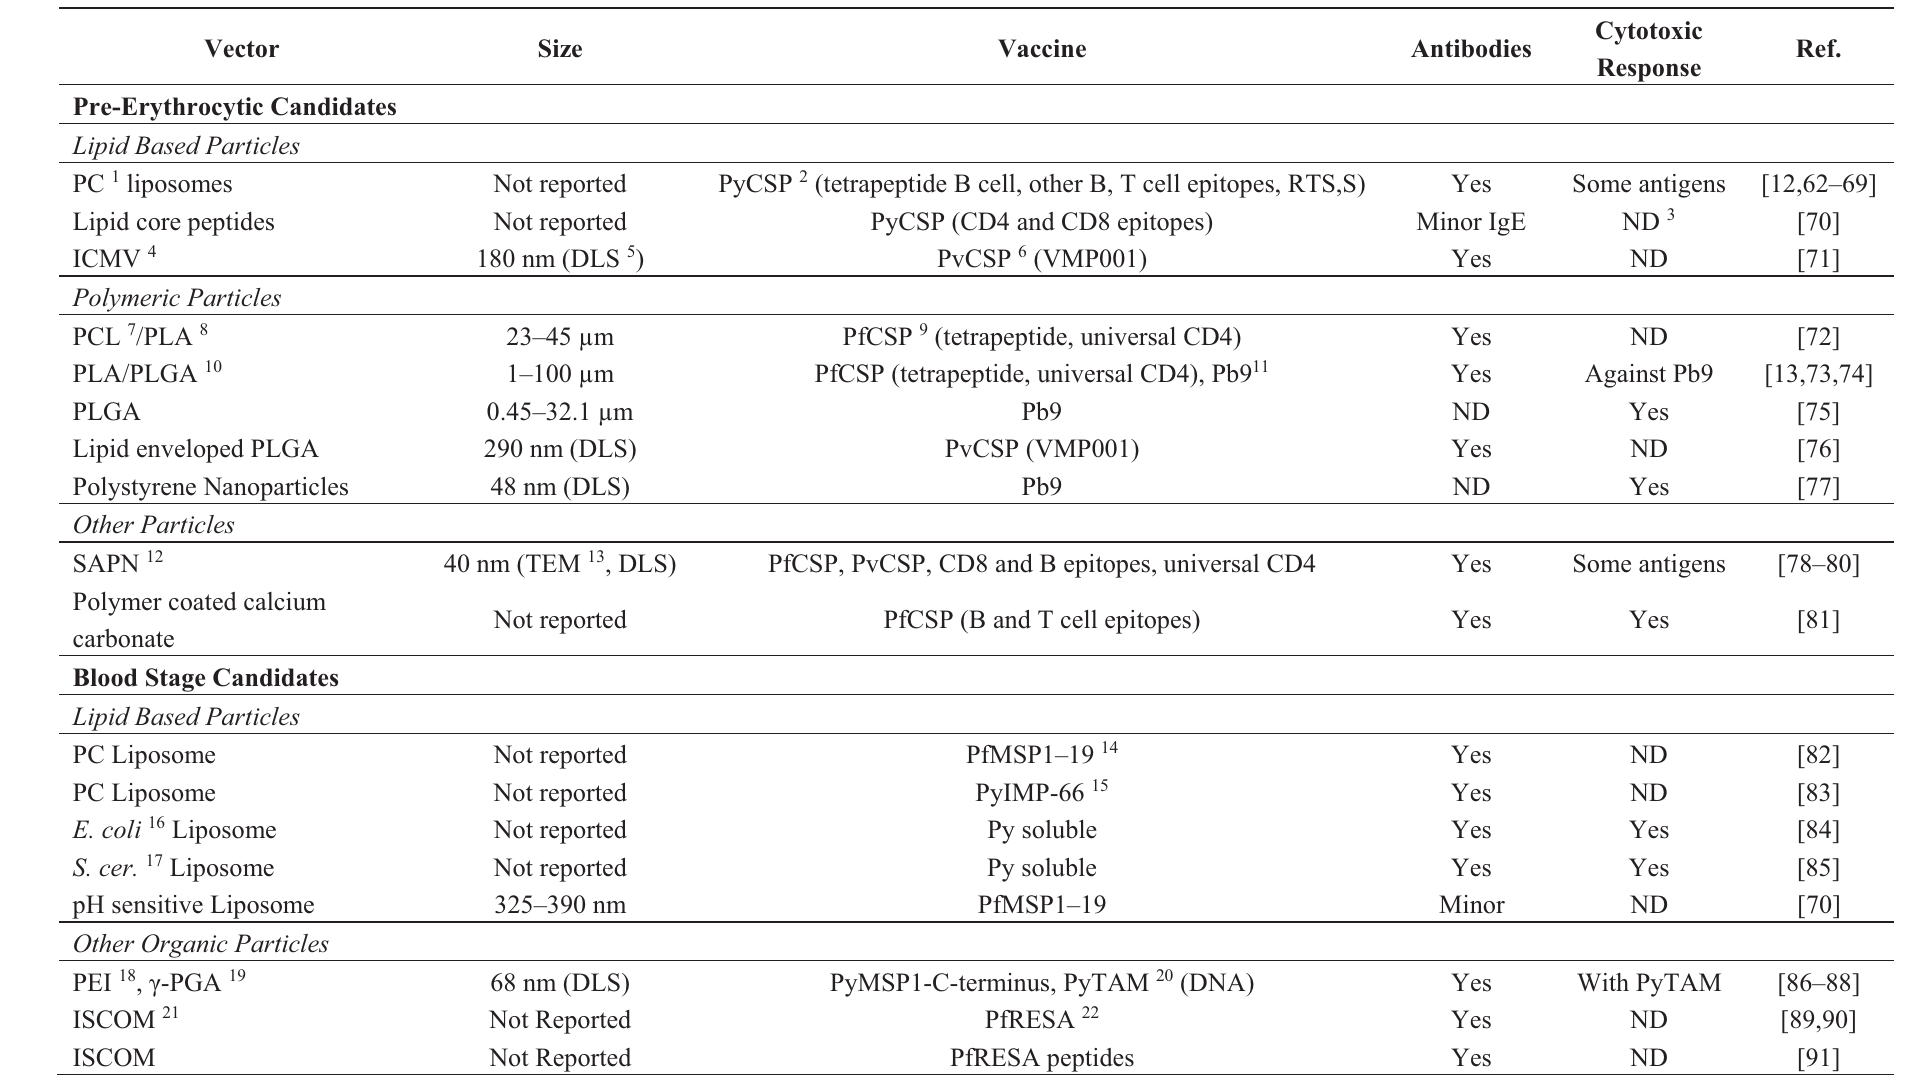
Table 1. Summary of clinical and preclinical studies incorporating novel synthetic vector